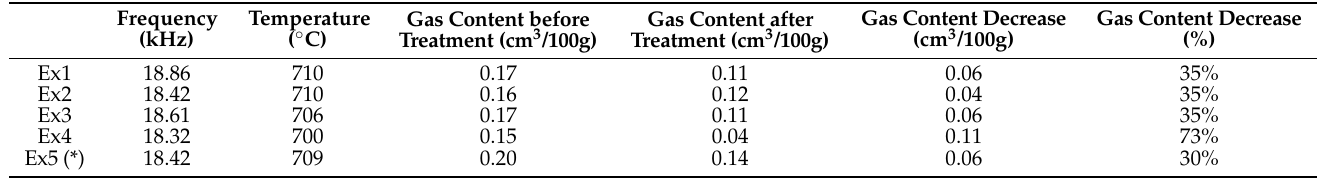
Table 1. Degassing achieved by contactless ultrasound treatment.